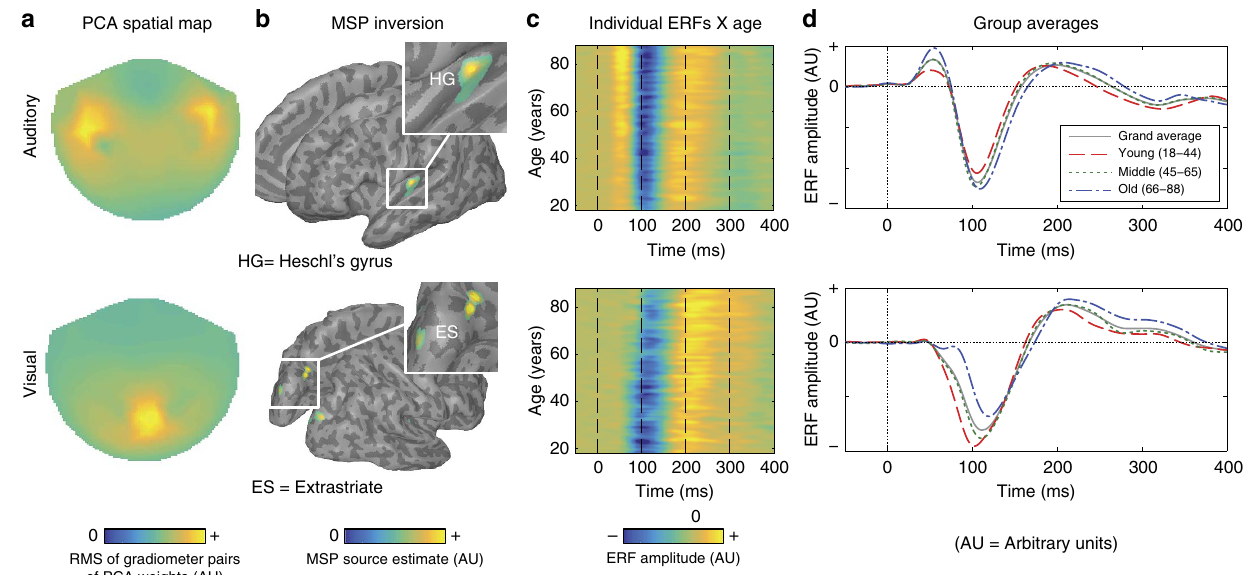
Figure 1 | Principal component analysis (PCA) and delay estimation of auditory and visual evoked responses. ( a ) Two-dimensional topographical MEG sensor plot of the first spatial component derived using PCA in the Passive task. Values represent the root mean square (RMS) of each pair of gradiometers. ( b ) Group Multiple Sparse Prior (MSP) source reconstruction based on the spatial component shown in a (cluser peak MNI coordinates: right HG ¼ [ þ 38, (cid:2) 22, þ 8], left ¼ [ (cid:2) 38, (cid:2) 26, þ 8]; right V2 ¼ [ þ 14, (cid:2) 96, þ 20], left ¼ [ (cid:2) 14, (cid:2) 96, þ 20]; ES right ¼ [ þ 16, (cid:2) 74, þ 24], left ¼ [ (cid:2) 16, (cid:2) 74, þ 20]). ( c ) Heat-maps illustrating the mean time course for each participant from the first temporal component of the PCA. Data are smoothed in the y direction for visualization only (Gaussian width ¼ 5 subjects). ( d ) Group average time courses for each of three age groups (18–44, 45-65, 66–88 years). Because all of our analyses are based on principal components, the y axis of plots have arbitrary